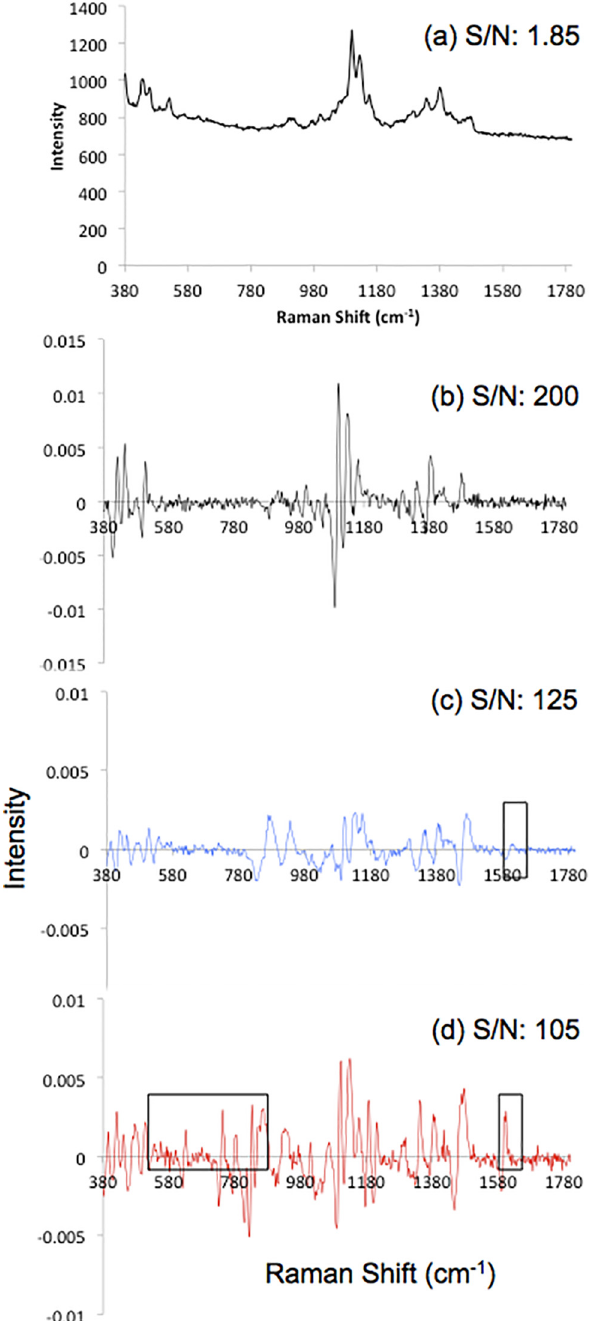
Fig 2. Spectra of the paper microfluidic device before and after swabbing of pharmaceuticals. (a) Standard Raman spectra of paper device and (b)-(d) WMRS spectra of paper only, paper + paracetamol and paper + ibuprofen respectively. S/N quoted are measured for the 1089 cm -1 band and are an average of 10 spectra of each individual